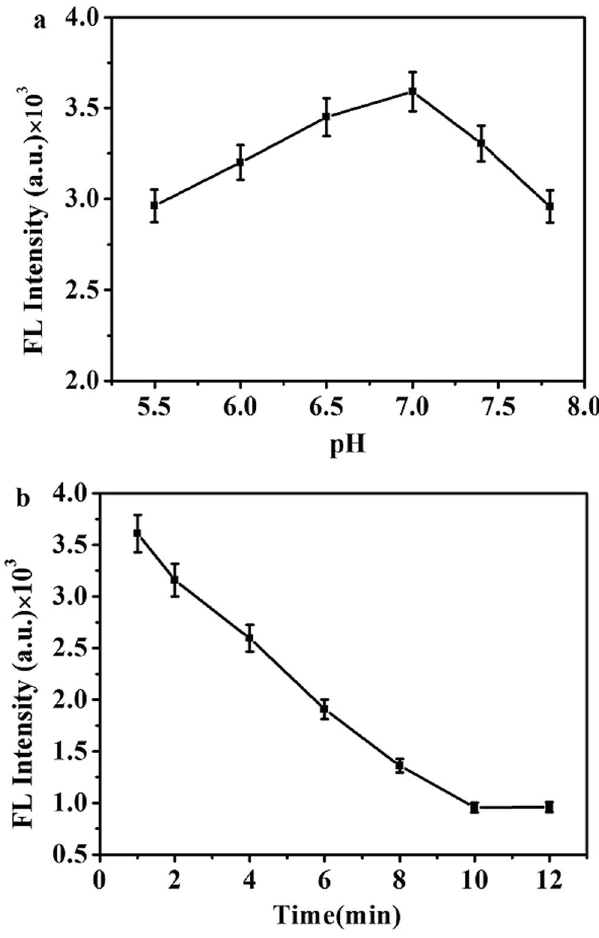
Figure 3. ( a ) pH dependence of fluorescence spectra of DNA-AgNCs under the following conditions: 10 μ M K + ions with varying pH values of PB(20 mM), incubated for 10 min at room temperature. ( b ) Time-dependent fluorescence intensity changes of the DNA-AgNCs for 10 μ M K +